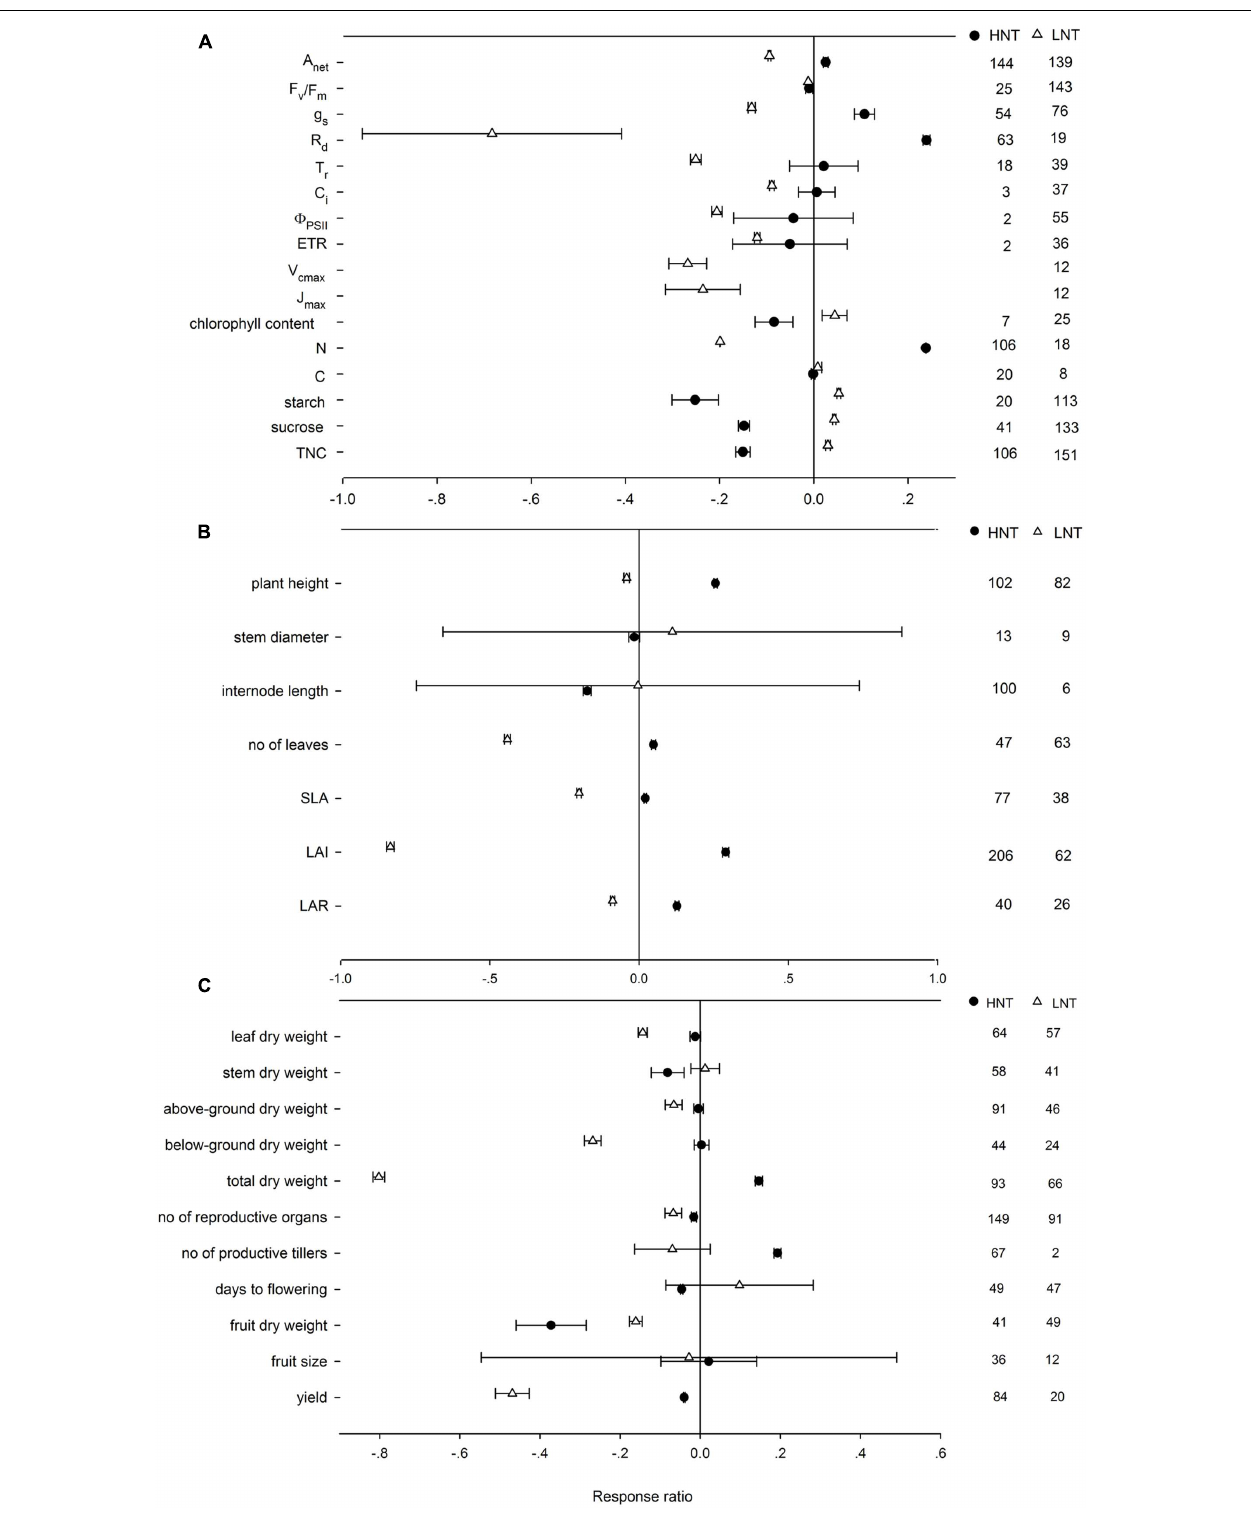
Frontiers in Plant Science |